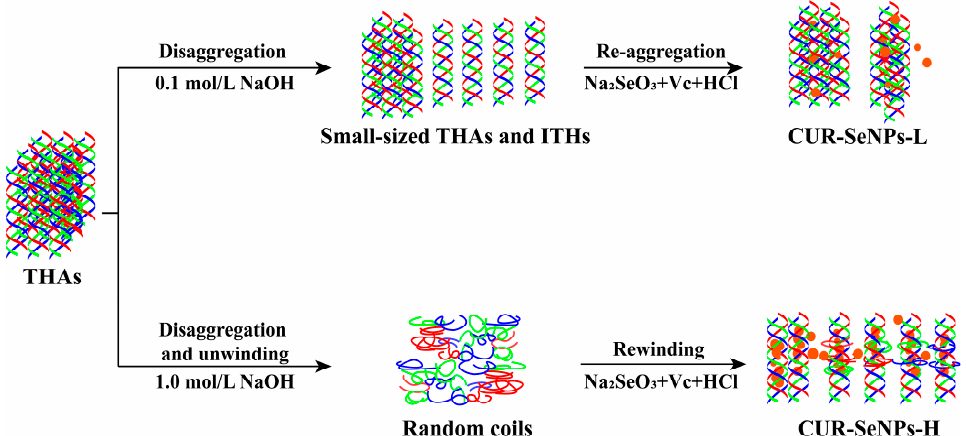
Figure 7. The construction mechanisms of CUR-SeNPs prepared under different AN pretreat-